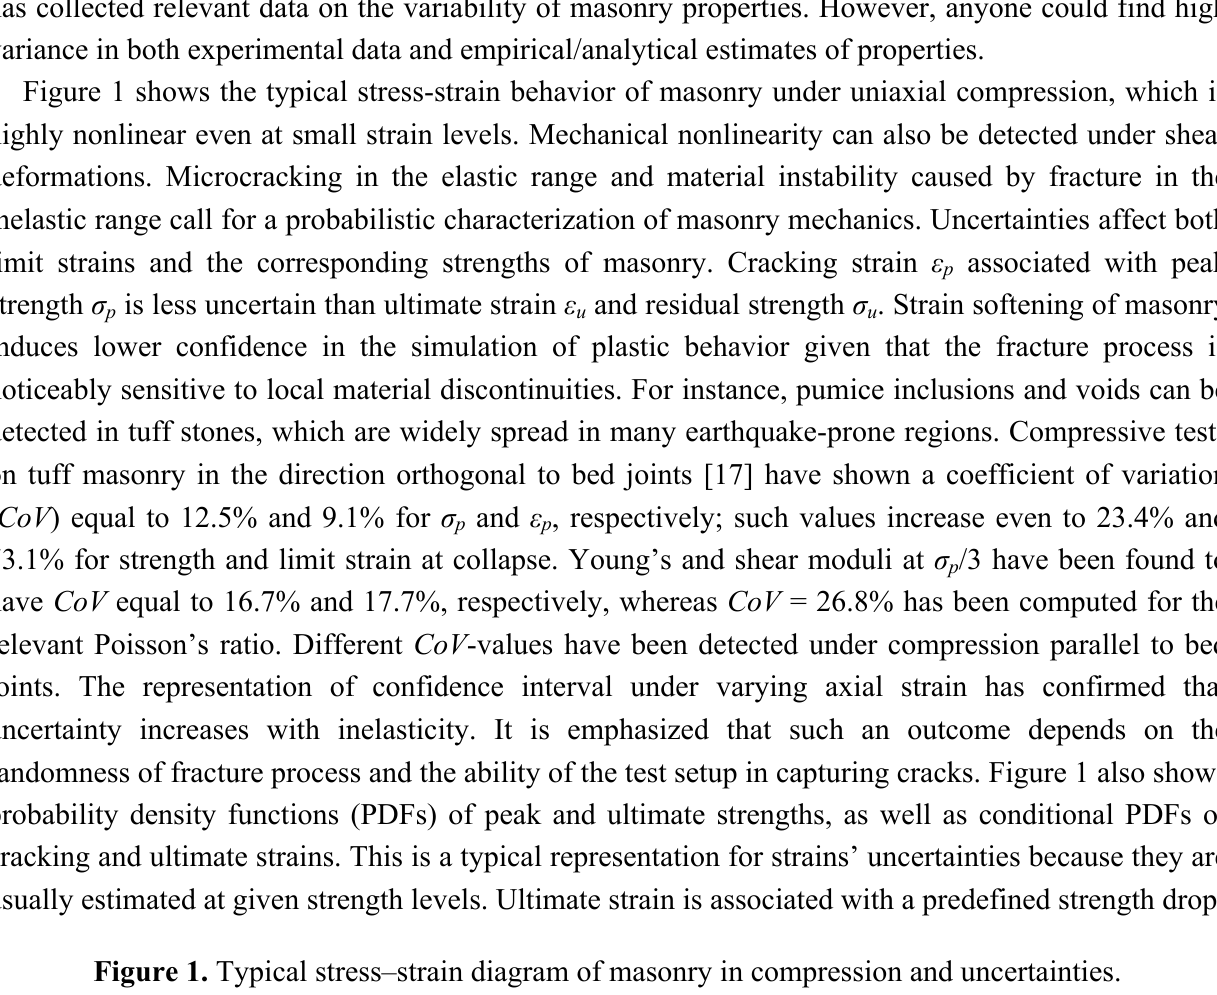
Figure 1. Typical stress–strain diagram of masonry in compression and